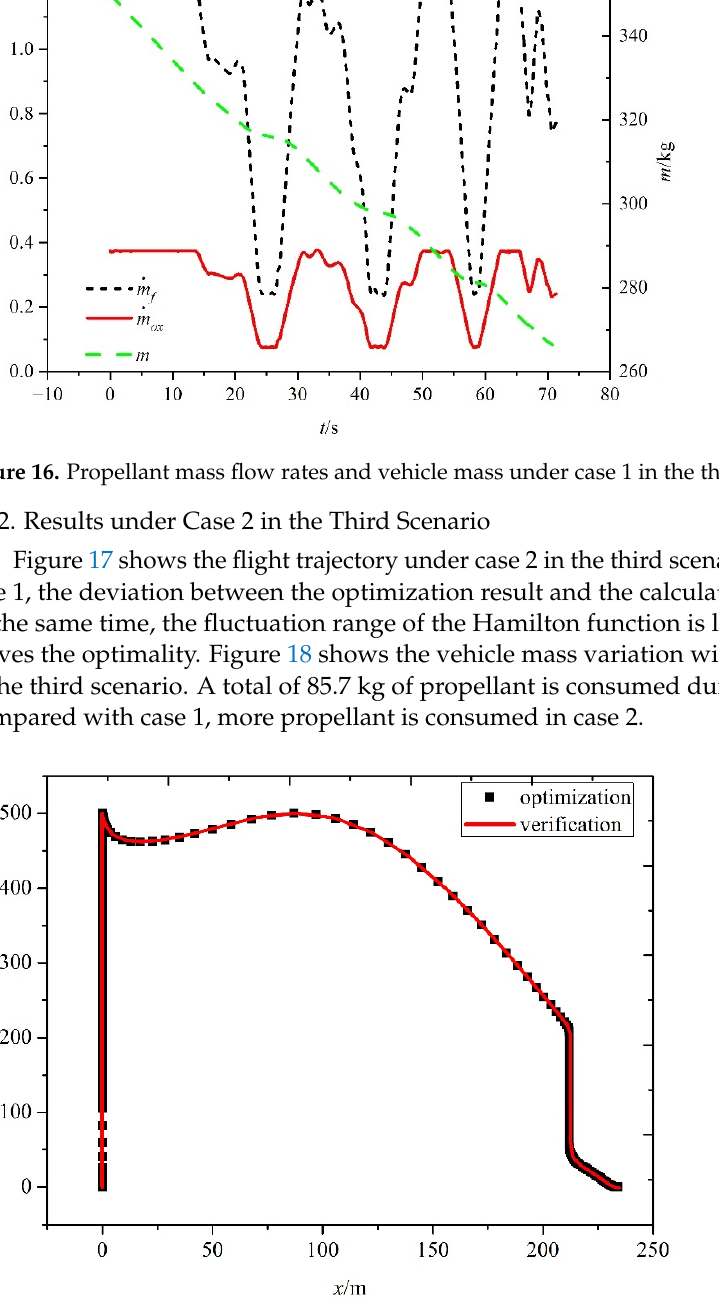
Figure 18. Vehicle mass under case 2 in the third scenario vs. time. Figure 19 shows the thrust variation with time under case 2 in the third scenario. It can be seen that a somewhat large fluctuation occurs in the acceleration translation. In general, as seen in two cases in the third scenario, the thrust does not express the similar bang–bang control type in autonomous landing because of the small flight distance and greater constraints. Figure 20 shows the propellant mass flow rates and the vehicle mass variation with time under case 2 in the third scenario. Compared with case 1 in the third scenario, the fluctuation of the propellant mass flow rates is reduced, and there is a relatively violent fluctuation in the accelerated translation stage. Further, it shows that for complex condi- tions, the weight method has some limitations in removing fluctuations. 5.4. Comparison among Three Scenarios Considering the compatibility of the three flight scenarios, the consumed propellant mass should be determined by the third scenario. Moreover, it is appropriate to carry 85.7 kg of propellant according to case 2 in the third scenario, as shown in Table 5, because the